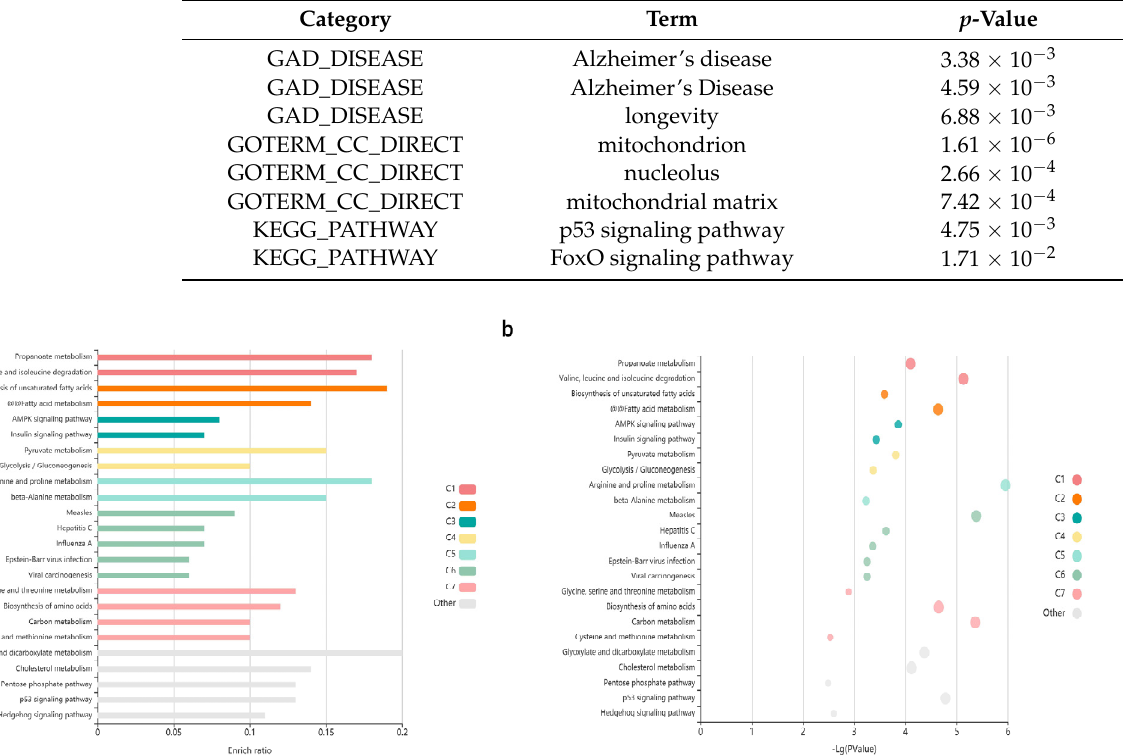
Figure 5. The enriched KEGG pathways of differentially expressed genes. ( a ) The enriched KEGG pathways of differentially expressed genes visualized in the bar plot. Each row represents an enriched function, and the length of the bar represents the enrich ratio, which is calculated as “input gene number”/”background gene number”. The color of the bar represents different clusters. For each cluster, if there are more than 5 terms, the top 5 with the highest enrich ratio will be displayed. The enrichment analysis was conducted using KOBAS. ( b ) The enriched KEGG pathways of differentially expressed genes visualized in bubble plot. Each bubble represents an enriched function, and the size of the bubble is from small to large: [0.05,1], [0.01,0.05], [0.001,0.01], [0.0001,0.001], [1 × 10 − 10 , 0.0001] and [0,1 × 10 − 10 ]. The color of the bubble is the same as the color of the bar above, which represents different clusters. For each cluster, if there are more than 5 terms, the top 5 with the highest enrich ratio will be displayed. The enrichment analysis was conducted using KOBAS.